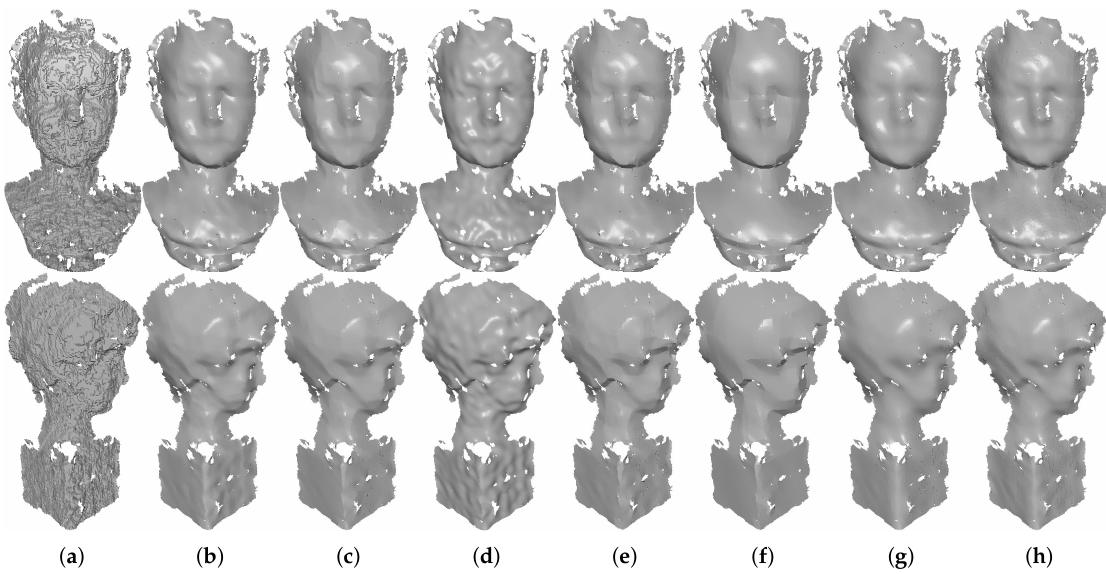
Figure 8. Denoising results of Boy and Girl captured by Kinect v1. From left to right: ( a ) noisy meshes, denoising results produced by ( b ) our method TS; ( c ) HO [1]; ( d ) RHM [14]; ( e ) TV [21]; ( f ) (cid:96) 0 [20]; ( g ) localBF [12]; and ( h ) globalBF [12], respectively.